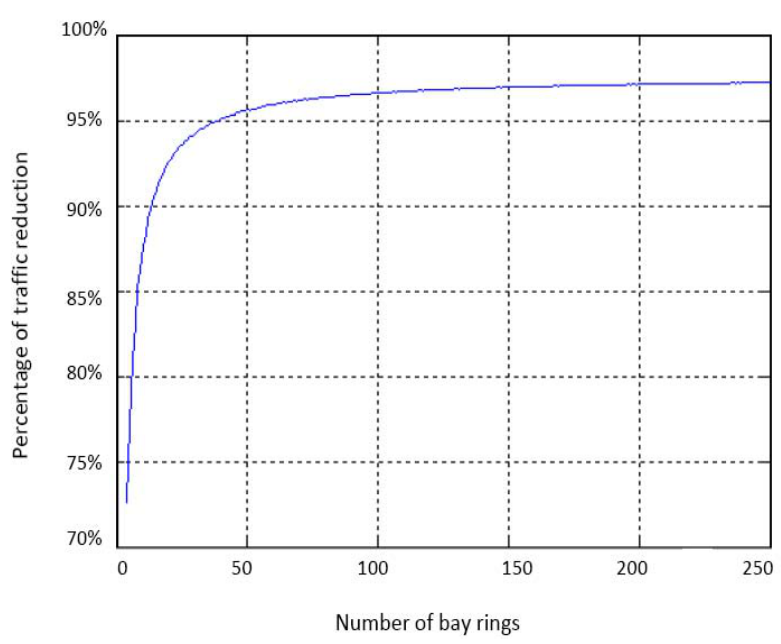
Figure 10. Percentage of the network-traffic reduction when applying the DVP algorithm on the network from Figure